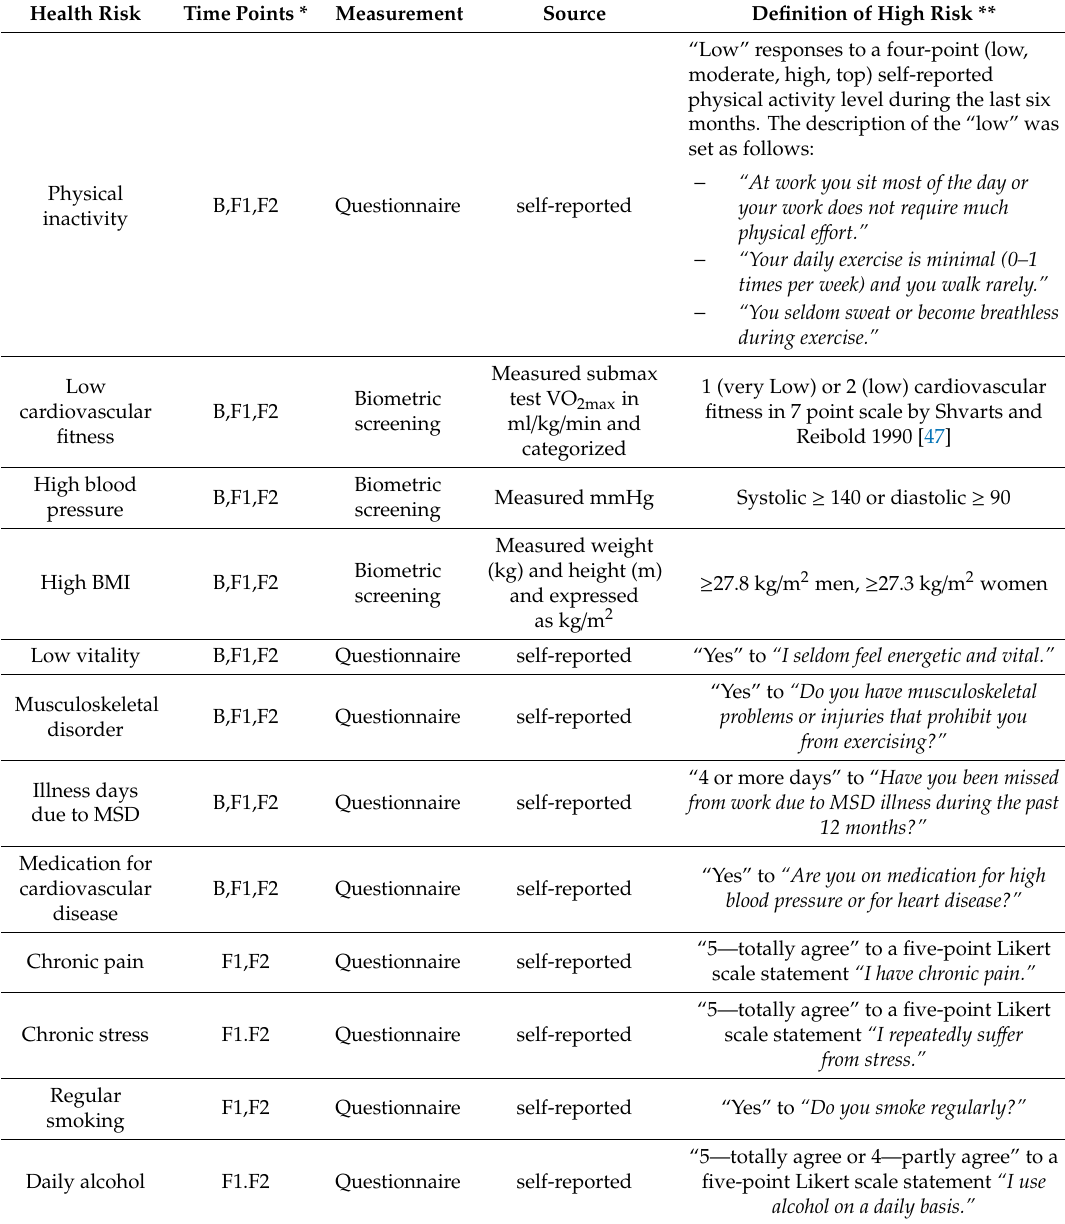
Table 1. Health risks and